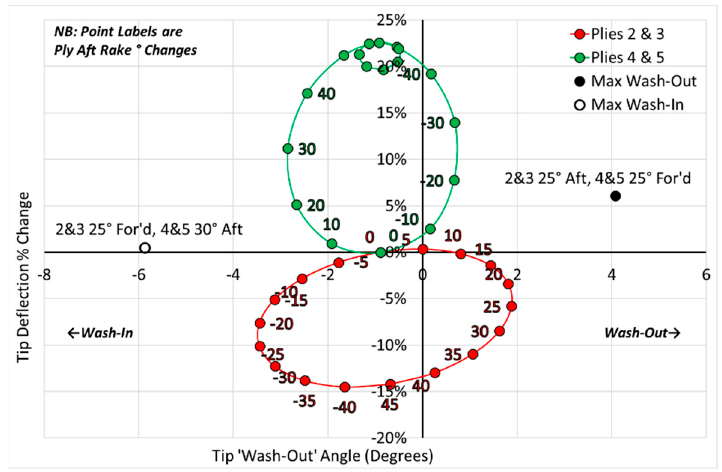
Figure 24. One-way FSI variation of tip deflection and twist with ply angles.